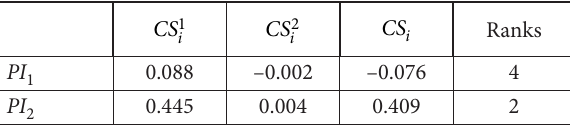
Table 2. The comprehensive scores and ranks of the